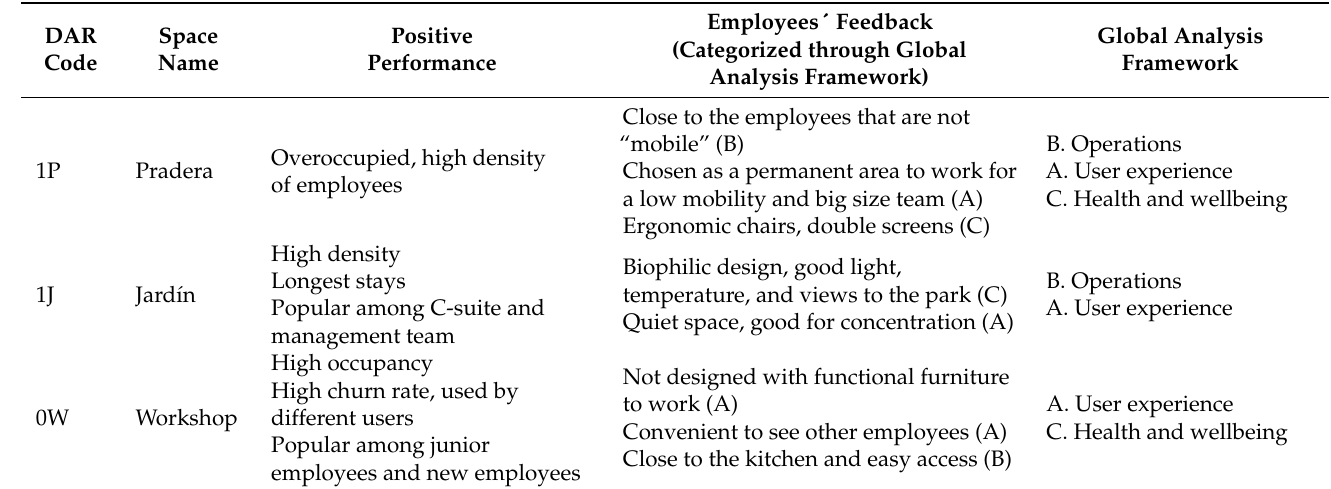
Table 4. Spaces with positive performance and relevant employee feedback.